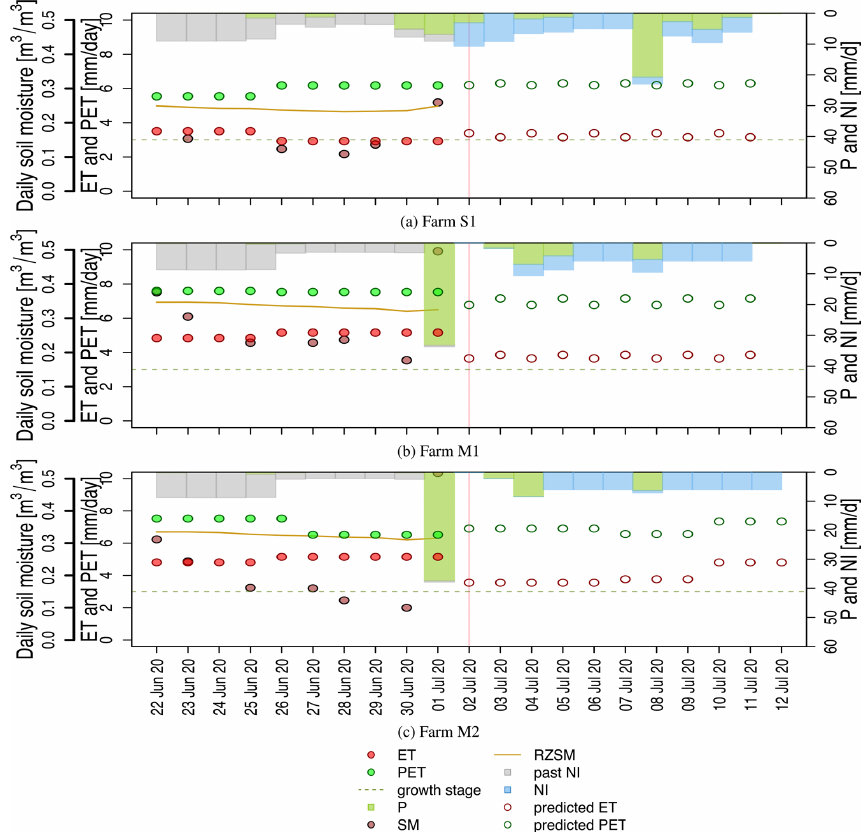
Figure 8. Predictions from Farms S1, M1, and M2 for 2 July 2020. Total predicted values for the remaining 10d are as follows. For Farm S1, PET is 62mm, ET is 33mm, P is 36mm, and NI is 52mm. For Farm M1, PET is 70mm, ET is 38mm, P is 18mm, and NI is 41mm. For Farm M2, PET is 76mm, ET is 4mm, P is 17mm, and NI is 43mm. The growth stage is the phenological stage of the